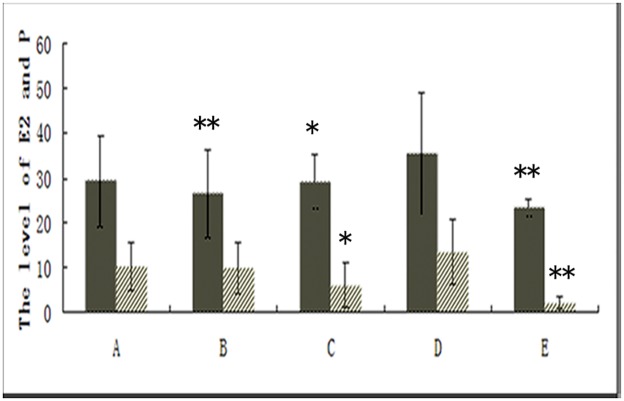
Effect of ginsenoside Rg3 on the levels of E2 (left panel) and P (right panel) in serum as assessed by the ECLI assay (n = 12).**: P<0.01, *:P<0.05 (by LSDt-test). Data are represented in means ± SDs. (A: Ginsenoside Rg3 low-dosage group; B: GinsenosideRg3 high-dosage group; C: Gestrinone group; D: Model control group; E: Ovariectomized group).